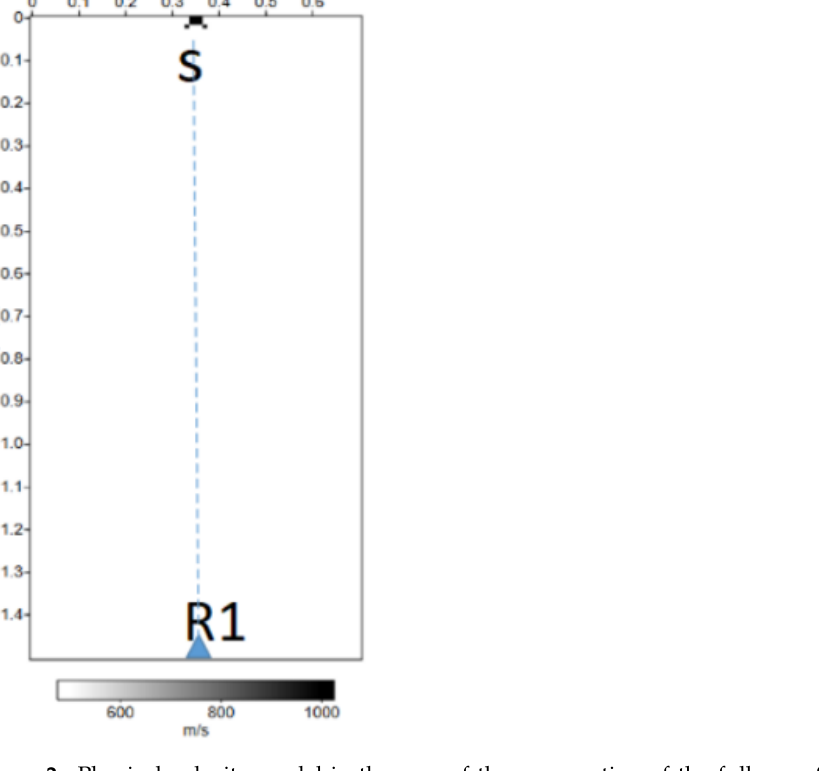
Figure 3. Comparison of travel time estimate of Model M1 (dashed blue line) with the full P-wavefield propagation model using finite differences.